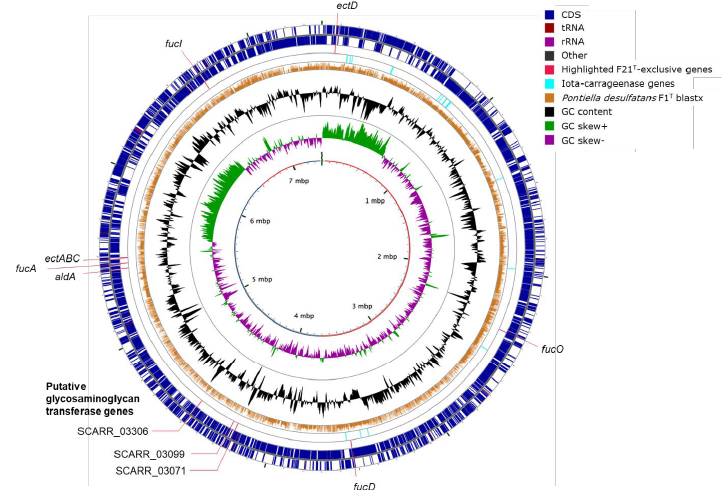
Figure 1. Circular visualization of the 7.4 Mbp strain F21 T genome. The inner circle shows the length of the genome in Mbp and distinguishes the contigs by an alternating red and blue color. Blastx hits with predicted proteins of strain F1 T are drawn with a height proportional to the amino acid identity percentage (0–100%). The outer ring shows coding sequences with a forward orientation, whereas the last-to-outer ring shows coding sequences with a backward orientation. Genes: aldA , lactaldehyde dehydrogenase; ectABCD , ectoine and 5-hydroxyectoine synthesis; fucA , L-fuculose phosphate aldolase; fucD , L-fuconate dehydratase; fucI , L-fucose isomerase; fucO , lactaldehyde reductase.